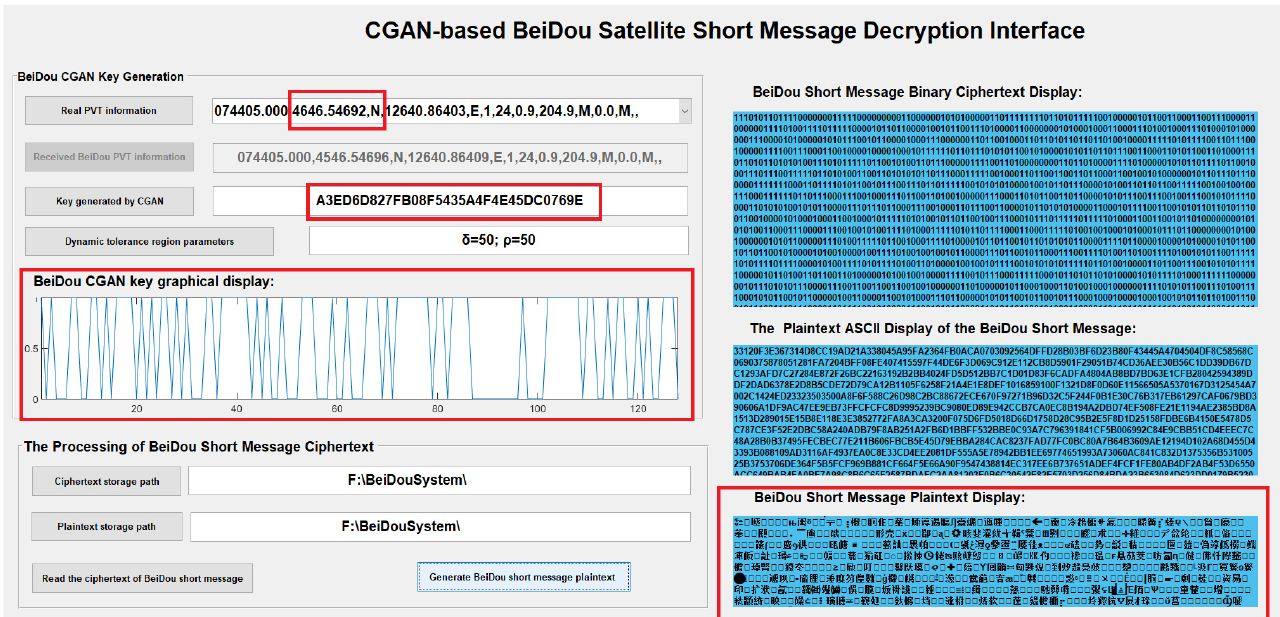
Figure 15. CGAN-based BeiDou satellite short message decryption interface.